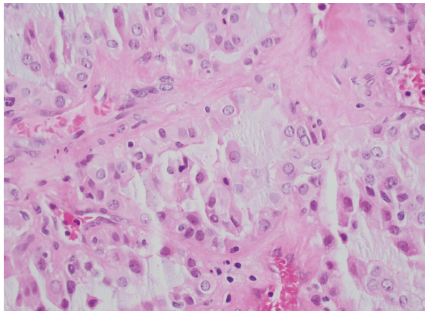
Figure 4: Tumor cells have occasionally prominent nucleoli and